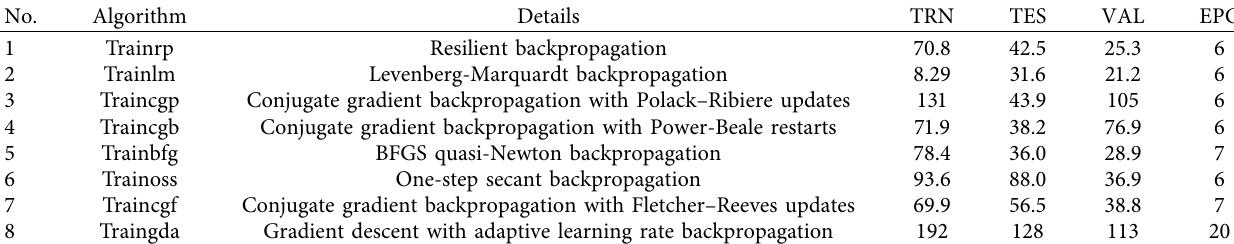
Table 3: Performance of the ANN model with different learning